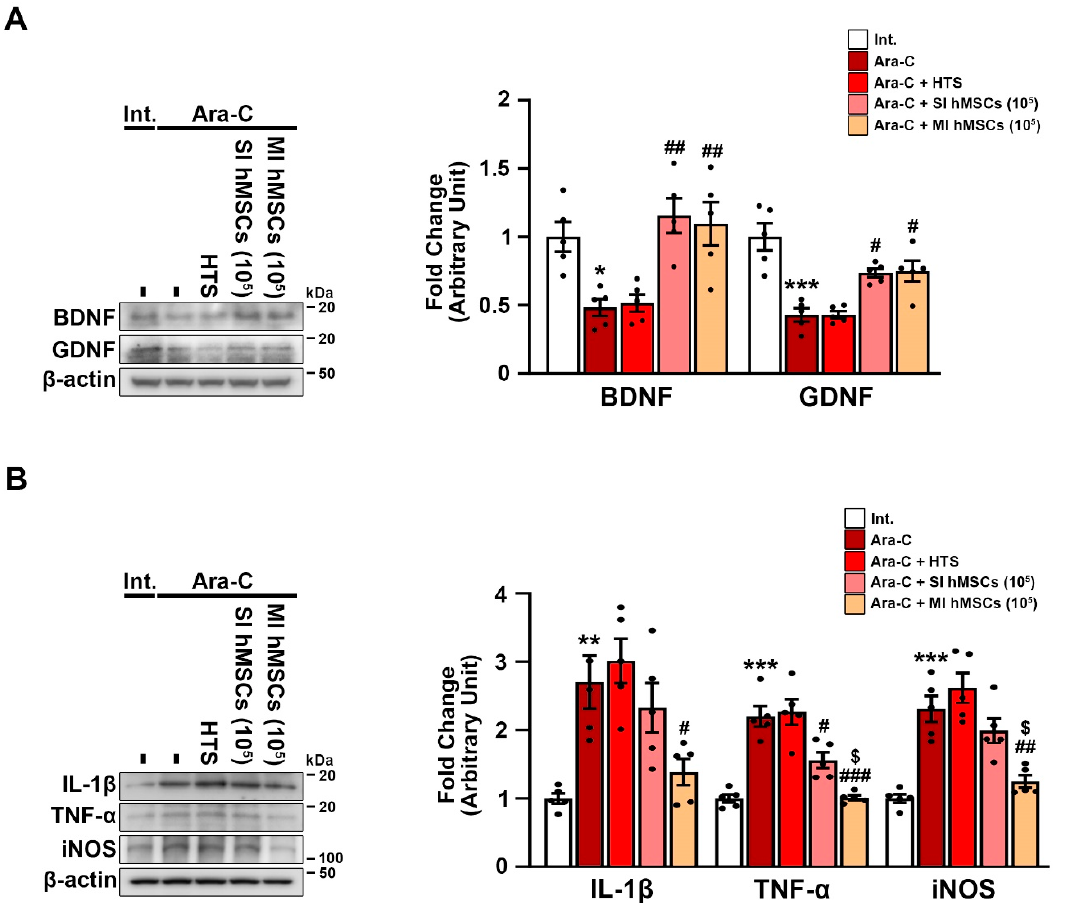
Figure 3. Treatment with hMSCs increases the protein levels of neurotrophic factors and decreases the protein levels of neurotoxic inflammatory molecules in the cerebellum of the CA mouse model. ( A ) Western blot analysis of GDNF and BDNF in the cerebellum at 12 weeks after hMSC treatment. * p < 0.05, *** p < 0.001 vs. intact mice; # p < 0.05, ## p < 0.01 vs. Ara-C-induced CA mice (one-way analysis of variance [ANOVA] with Tukey’s post hoc analysis; n = 5 for each group). ( B ) Western blot analysis of IL-1 β , TNF- α , and iNOS in the cerebellum at 12 weeks after hMSC treatment. ** p < 0.01, *** p < 0.001 vs. intact mice; # p < 0.05, ## p < 0.01, ### p < 0.001 vs. Ara-C-induced CA mice; $ p < 0.05 vs. single hMSC treatment in Ara-C-induced CA mice (one-way ANOVA with Tukey’ post hoc analysis; n = 5 for each group). Int., intact; Ara-C, cytosine arabinoside; HTS, hypothermosol; hMSCs, human mesenchymal stem cells; SI, single injection; MI, multiple injection; BDNF, brain- derived neurotrophic factor; GDNF, glial-derived neurotrophic factor; IL-1 β , interleukin-1 β ; TNF- α , tumor necrosis factor- α ; iNOS, inducible nitric oxide synthase.